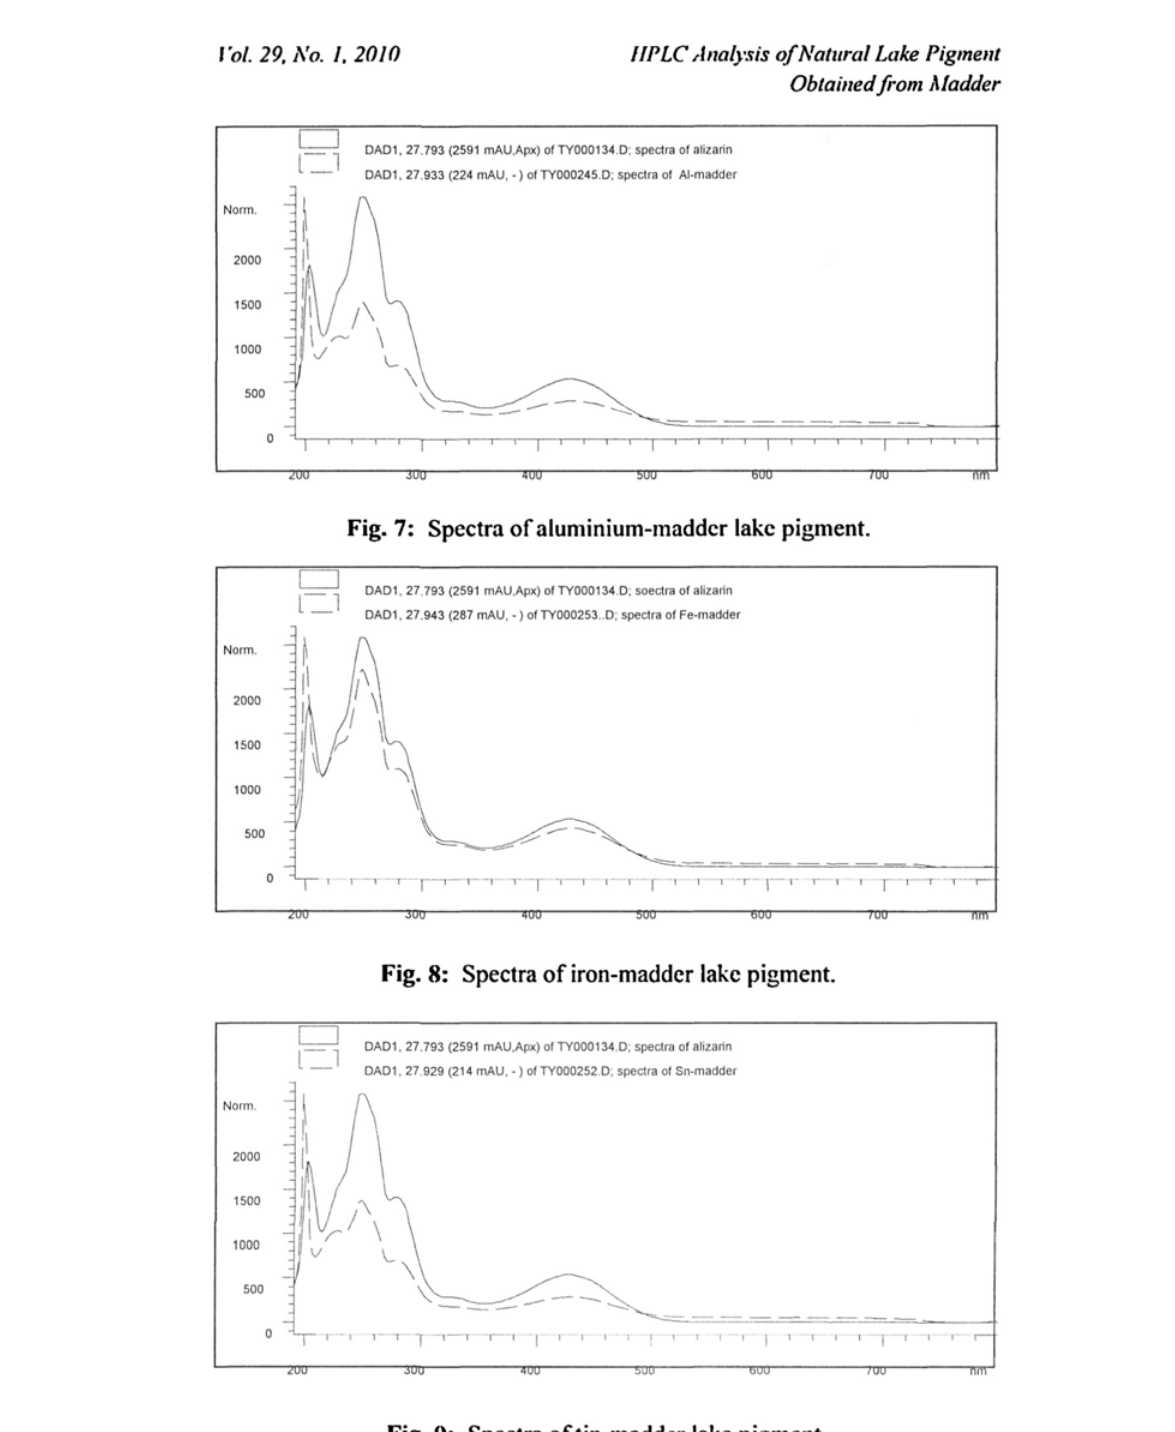
Fig. 9: Spectra of tin-madder lake